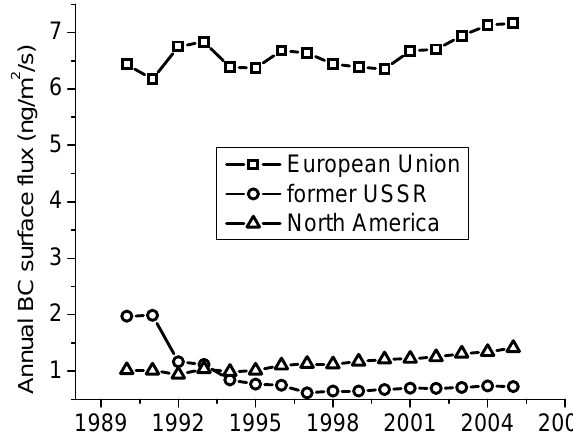
Fig. 1. Annual average BC surface flux (ng/m 2 /s) from European Union, the former USSR, and North America: